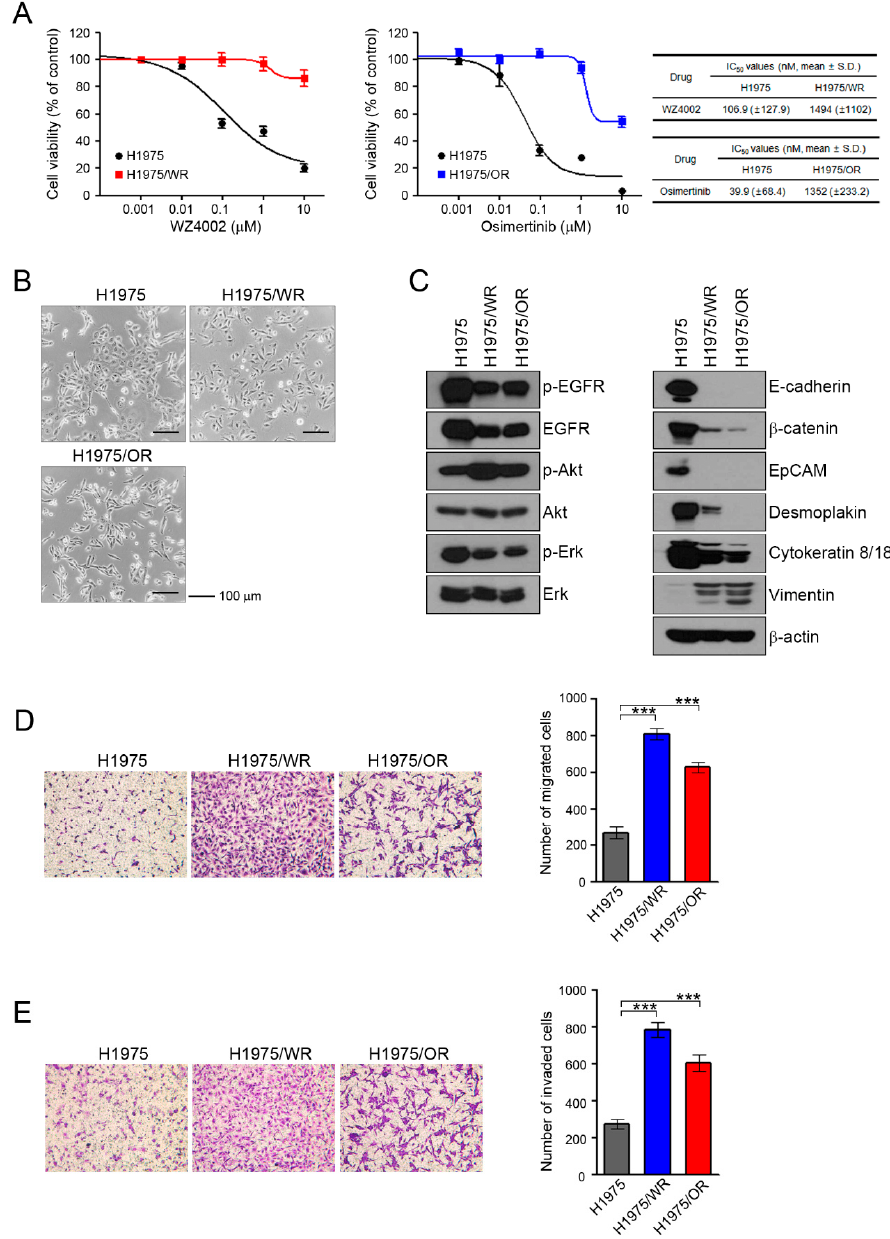
Figure 1. Induction of EMT in cells with acquired resistance to WZ4002 or osimertinib. ( A ) Cells were treated with the indicated doses of WZ4002 or osimertinib for 72 h, and cell viability was determined by an MTT assay. IC 50 values were calculated with GraphPad software through three independent experiments. ( B ) H1975 parental cells and the resistant cell lines (H1975/WR and H1975/OR) were evaluated for morphologic changes that were consistent with EMT using a light microscope. ( C ) EGFR signaling and EMT-related molecules were analyzed by western blotting. ( D, E ) Cells were seeded onto either collagen or Matrigel-coated polycarbonate filters to determine their migratory and invasive potentials, respectively. Cells were incubated in modified Boyden chambers for 24 h, and the cells that penetrated the filter were stained and counted using a light microscope. Experiments were conducted in triplicate. The bars represent the standard deviations. *** P < 0.0005 compared with H1975